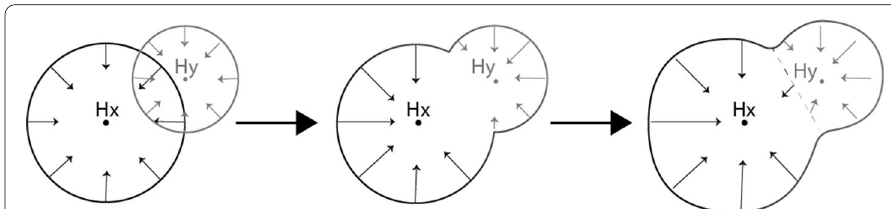
Fig. 7 Sketch of the circles’ deformation when two wells share the same aquifer. The size of the arrows is proportional to the heat flow into the well. In the central sketch, these arrows are larger. The right sketch represents the circles’ deformation as a consequence of a higher extraction rate. The name tag makes a reference to any couple of wells, sharing the same aquifer and whose circles